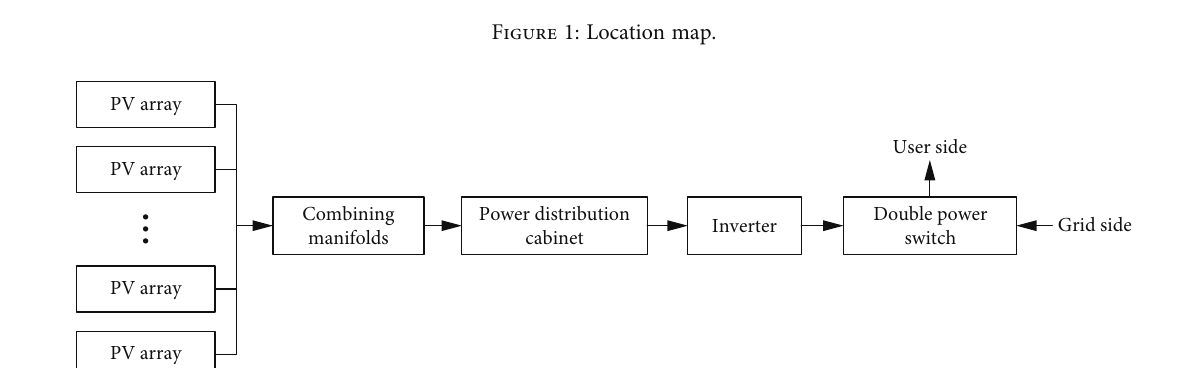
Figure 1: Location